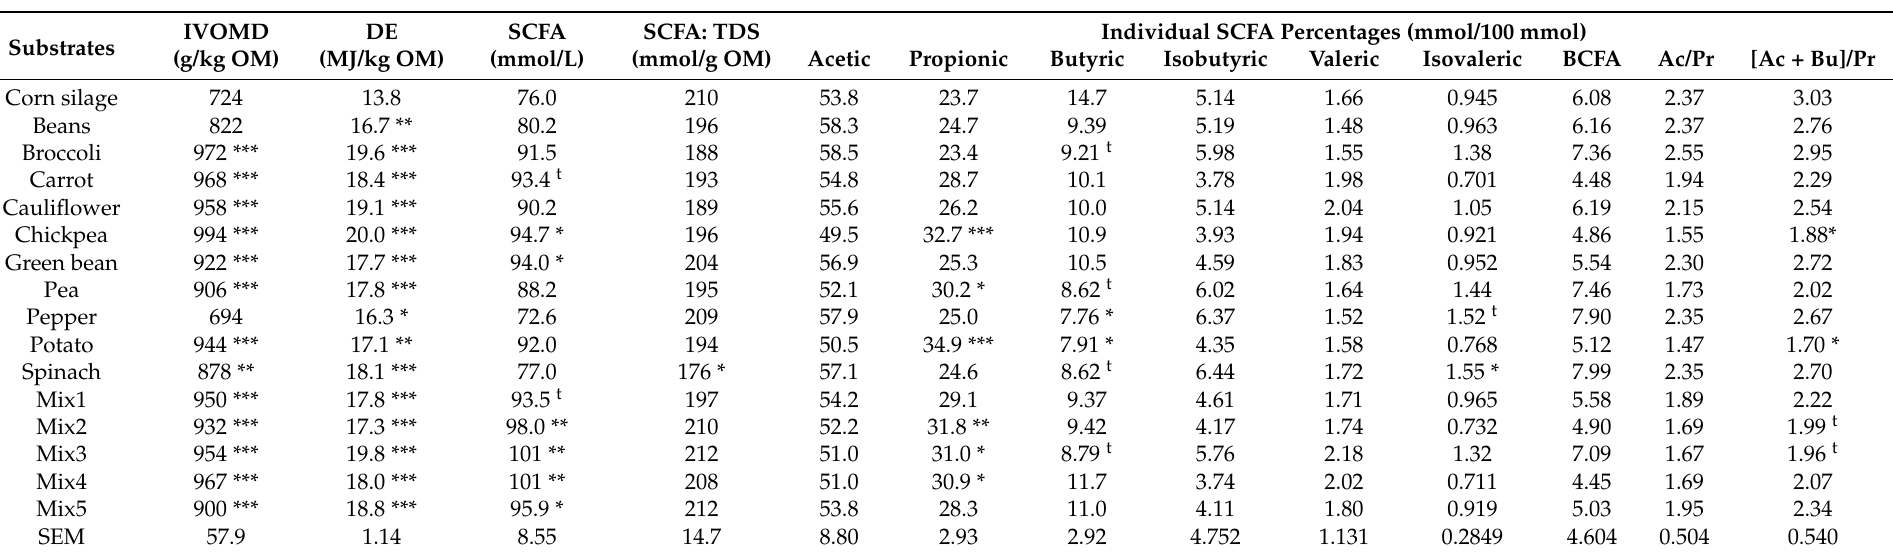
Table 4. In vitro digestibility, digestible energy, and fermentation parameters of corn silage and vegetable